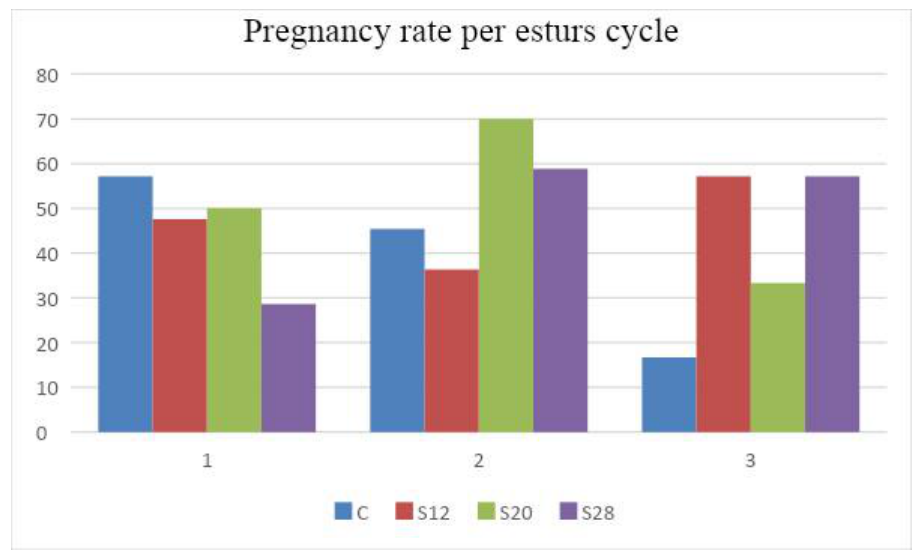
Figure 3. The effect of feeding different levels of SFH as a source of fiber on the pregnancy rate of Awassi ewes per estrus.